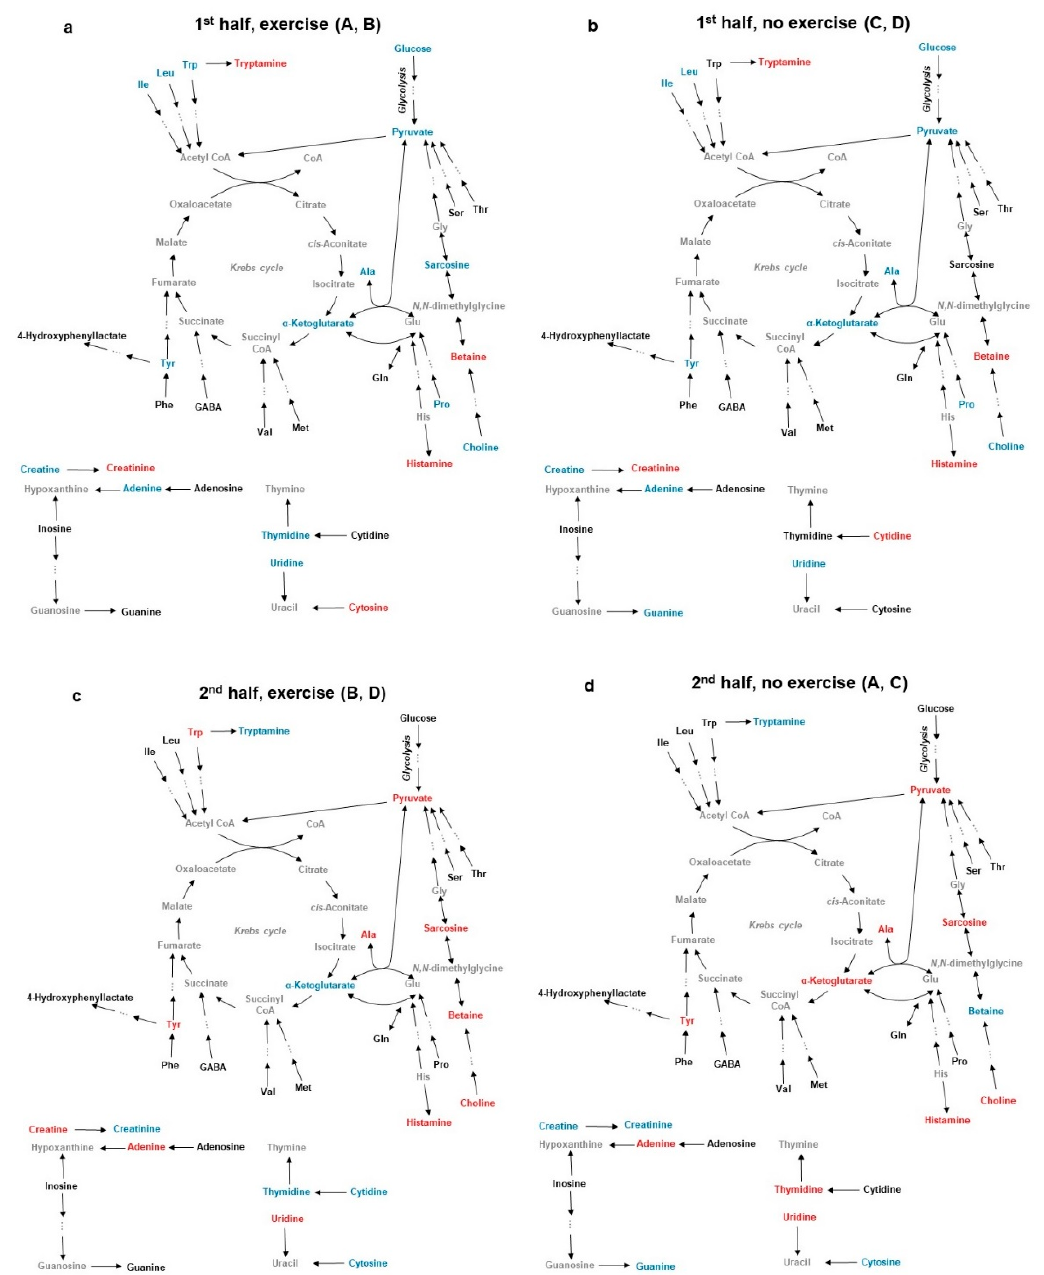
Figure 4. Map of metabolic pathways with highlighted urinary metabolites that changed with age and / or exercise training in ( a ) the exercising groups during the 1st half, ( b ) the non-exercising groups during the 1st half, ( c ) the exercising groups during the 2nd half, and ( d ) the non-exercising groups during the 2nd half of life. Metabolites in red, blue, or black increased, decreased, or did not change, respectively. Metabolites in grey were not identified.